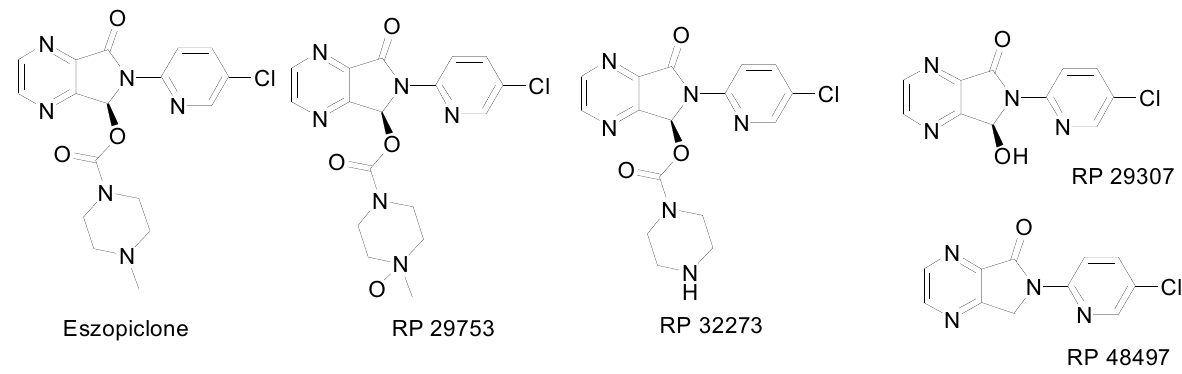
Figure 1 . Structures of eszopiclone and its metabolites.